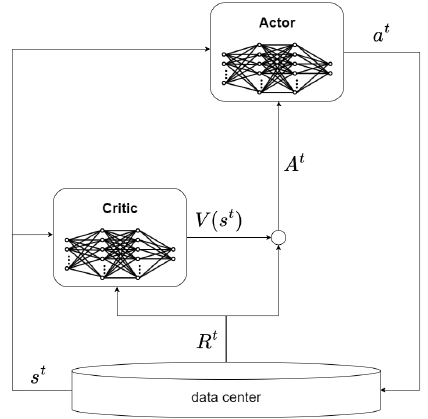
Figure 3. An illustration of the actor–critic in the